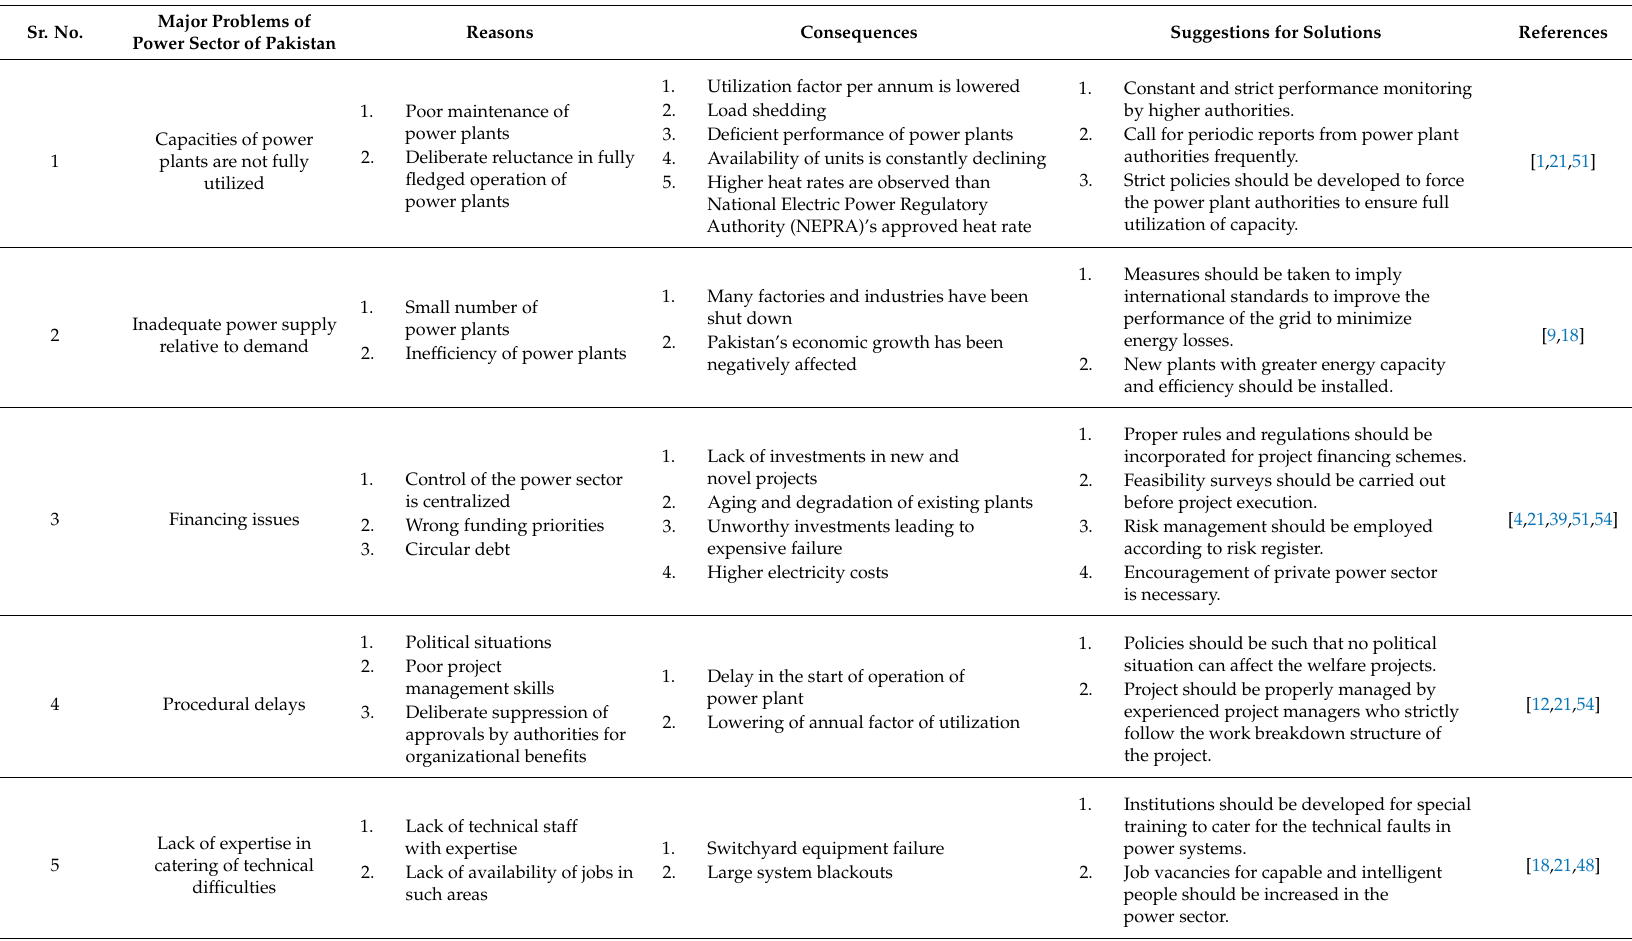
Table 22. Major problems of the power sector of Pakistan: reasons, consequences, and solutions. Sr.